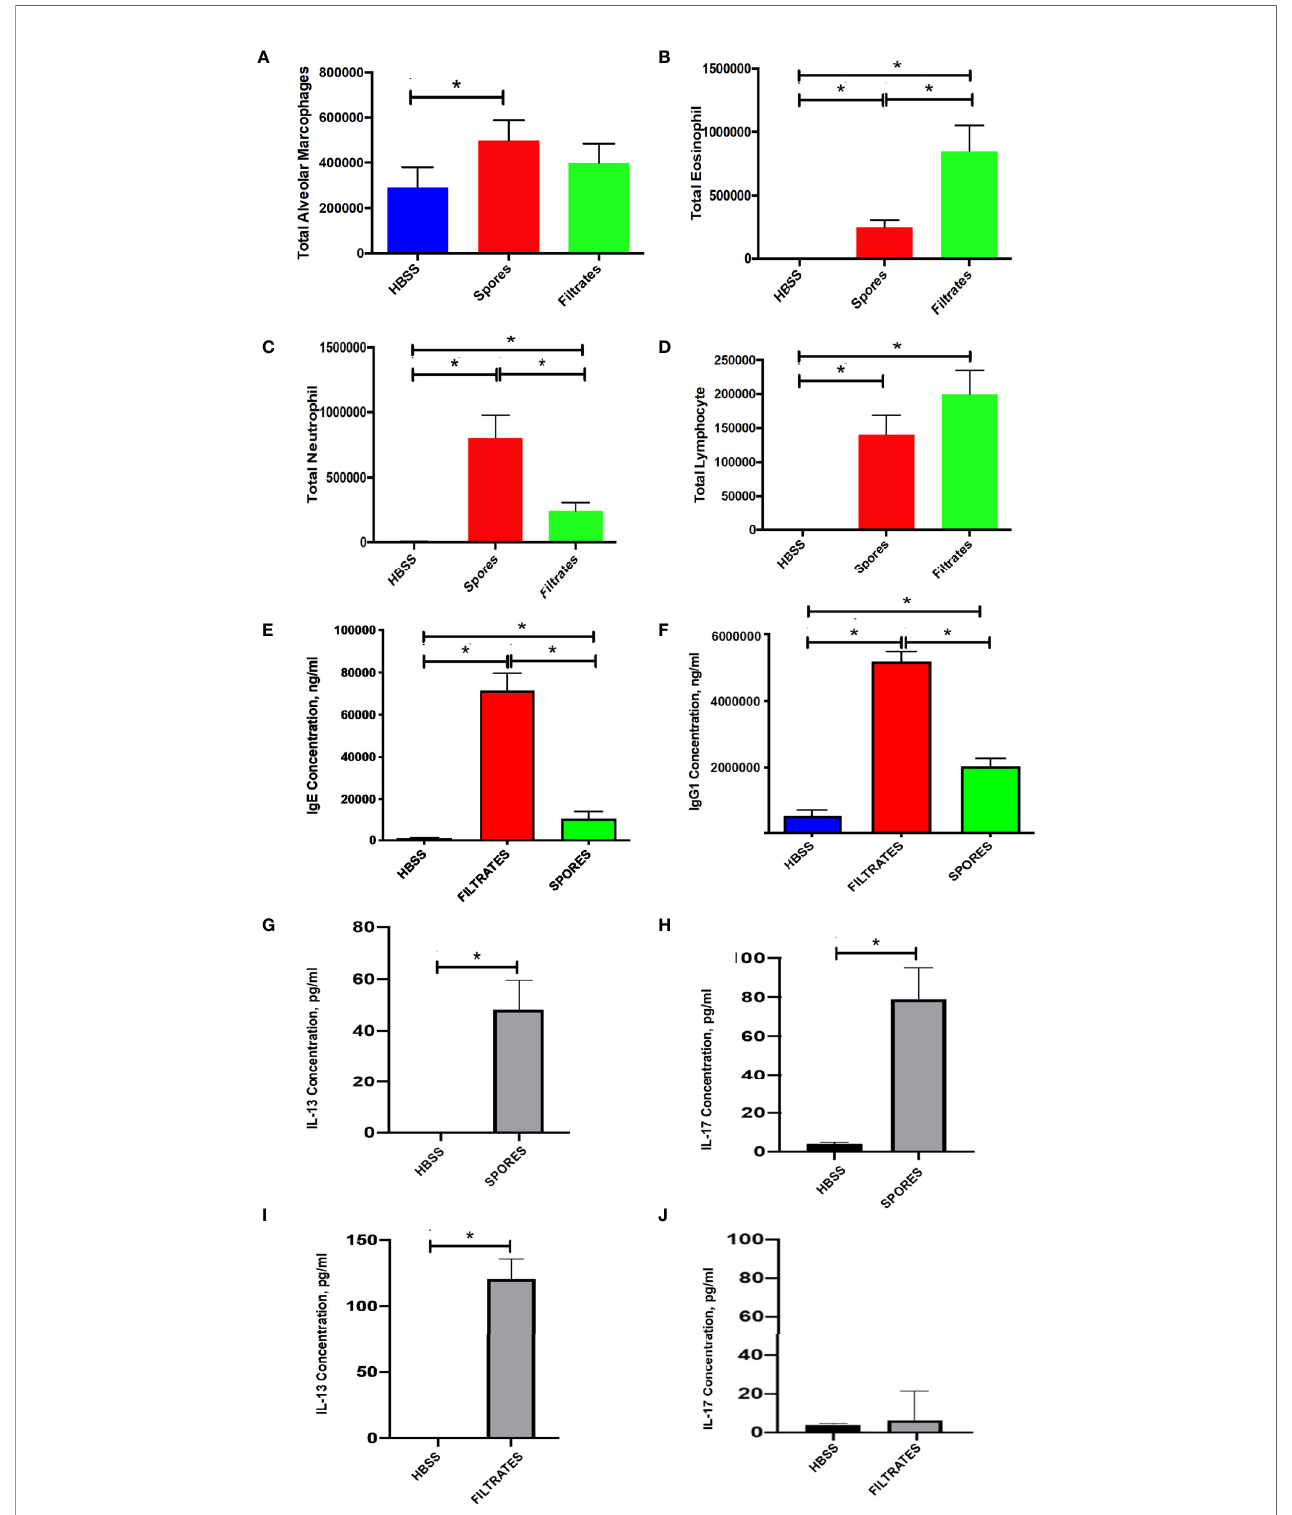
FIGURE 2 | BAL cell counts and serology in the fi ltrate or spore model. Data represents mean ± SEM, n = 8-10/group. *P < 0.05. (A – D) Differential cell counts. Different cell types in BAL samples were counted from these mice and presented as the total cell number. (E, F) Serological testing for total serum IgE and IgG1. (G, H) BAL IL-13 and IL-17 in the mice treated with spores. (I, J) BAL IL-13 and IL-17 in the mice treated with fi